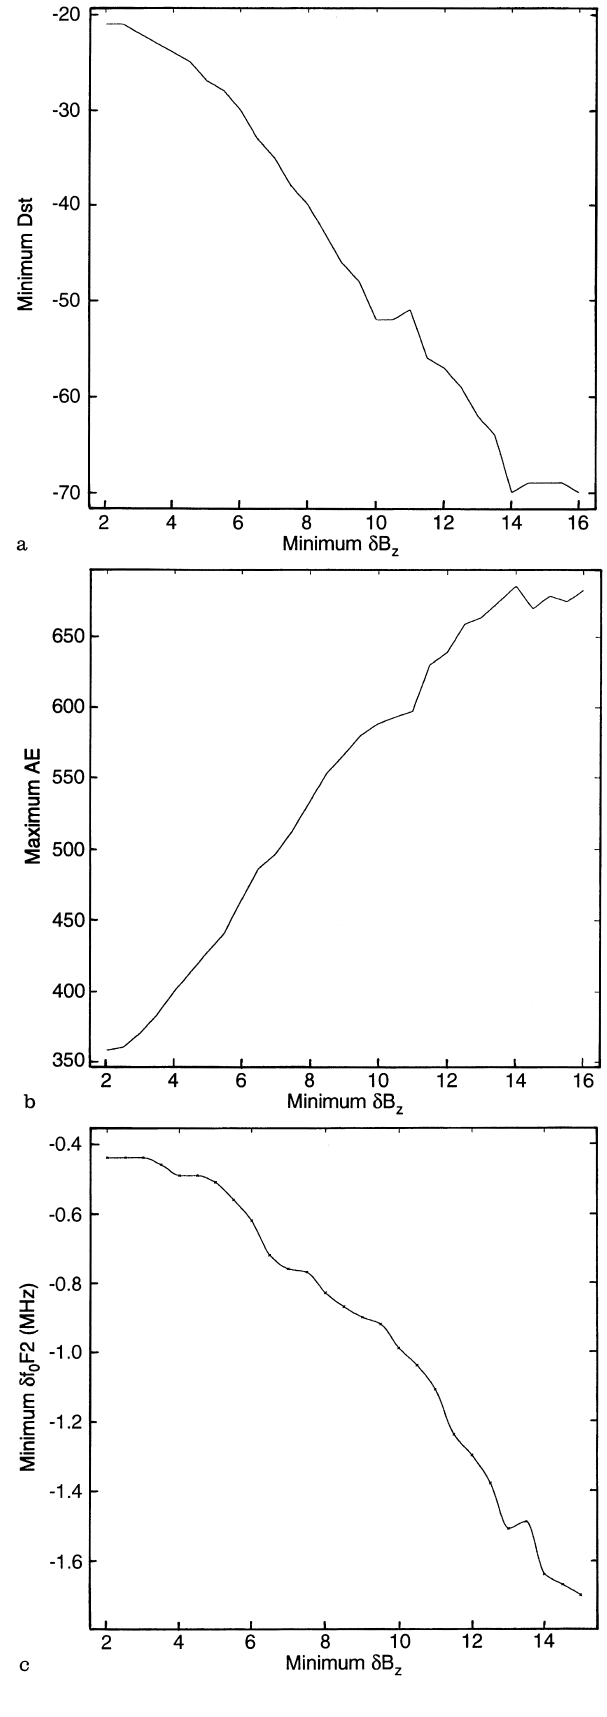
Fig. 9a–c. The geomagnetic and ionospheric responses as a function of the threshold size of the B z change in the southward turning (cid:100) B z : a the minimum in Dst; b the maximum in AE and c the minimum in (cid:100)